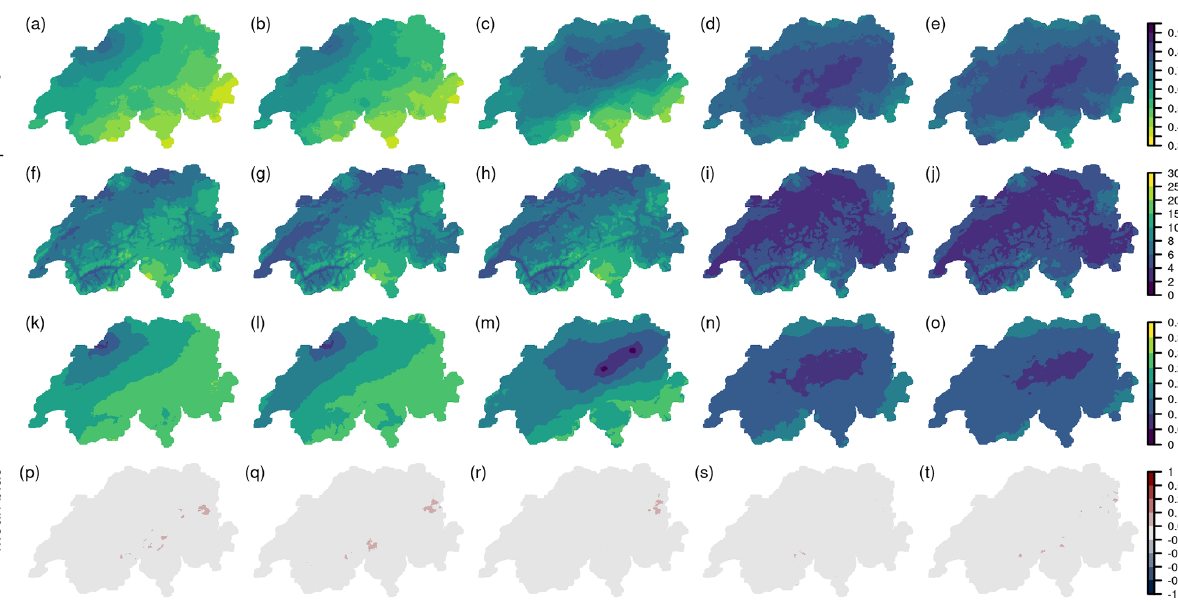
Clim. Past, 19, 703–729, 2023